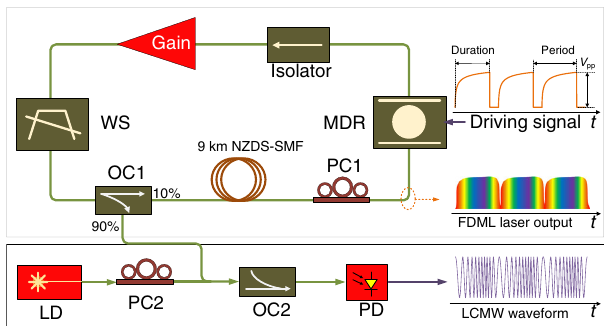
Fig. 1 Schematic diagram of the proposed LCMW generation system. WS wave-shaper, OC optical coupler, PC polarization controller, LD laser diode, NZDS-SMF none-zero dispersion-shifted single mode fi ber, PD